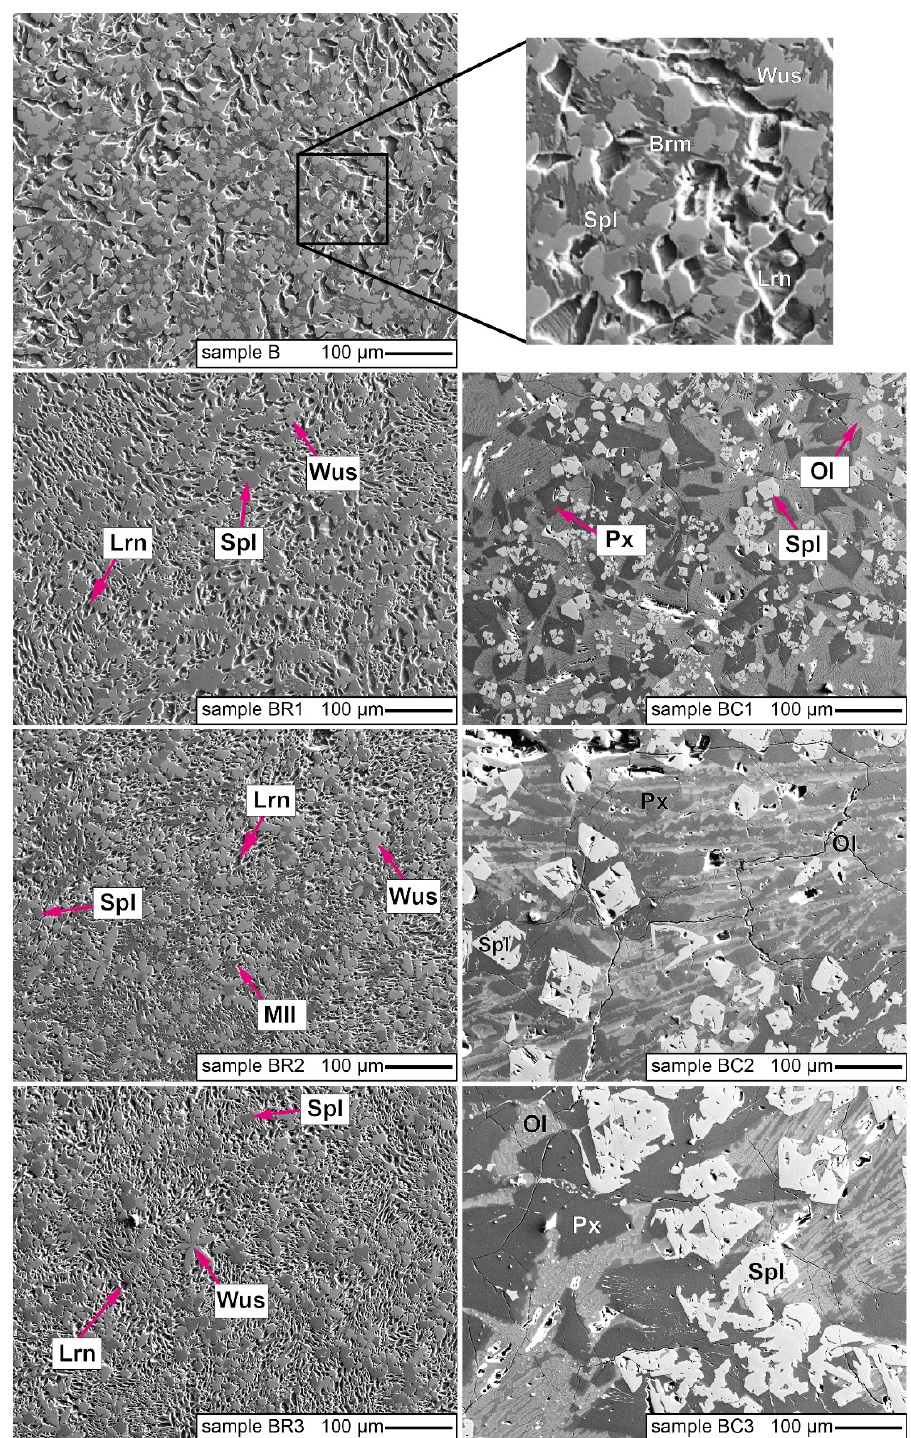
Figure 4. Secondary electron (SE) images of original sample B, remelted samples BR1–3, and remelted conditioned samples BC1–3 from pilot scale experiments. Numbers 1–3 represent different cooling rates with (1) fast cooling, (2) moderate cooling, and (3) slow cooling. Abbreviations according to Whitney and Evans (2010) [28]: wuestite solid solution (Wus), spinel solid solution (Spl), larnite (Lrn), olivine group (Ol), and melilite group (Mll). Phases identified via x-ray diffraction (XRD) and, if possible, via quantitative electron microprobe (EMP) analyses.